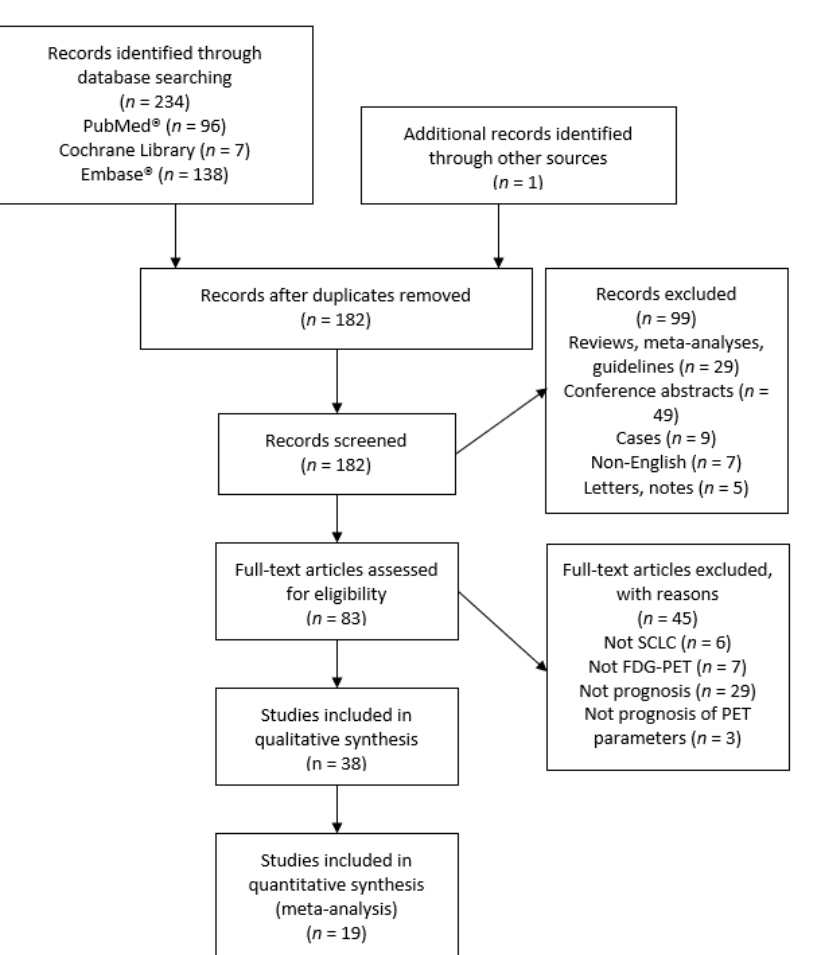
Figure 1. Prisma flowchart of included and excluded studies. SCLC: small cell lung cancer; FDG–PET: 2-deoxy-2-[ 18 F]fluoro-D-glucose positron emission tomography. Table 1. PET parameters. Definitions of PET parameters used in the included studies. PET Parameters in Included